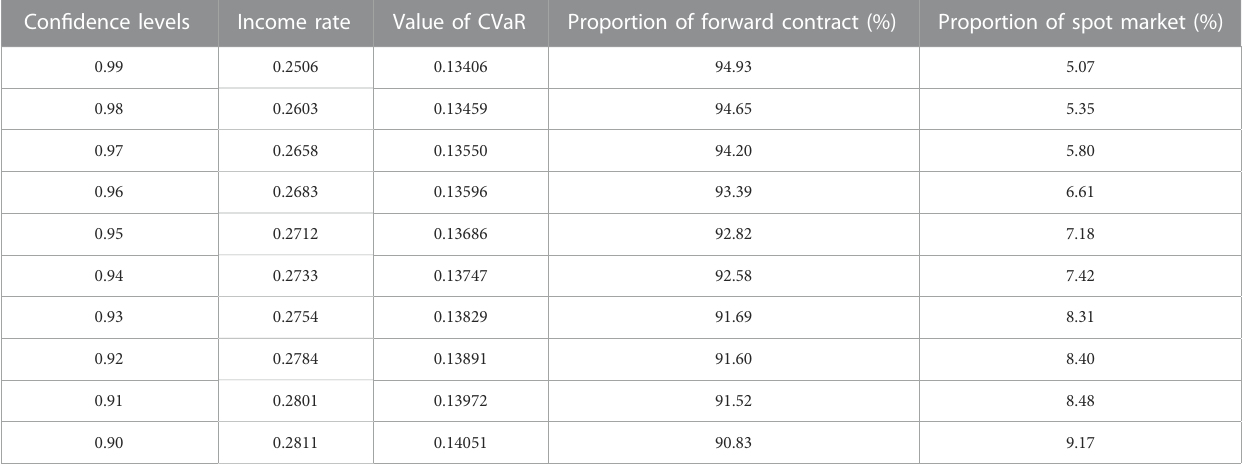
TABLE 4 Portfolios at different con fi dence